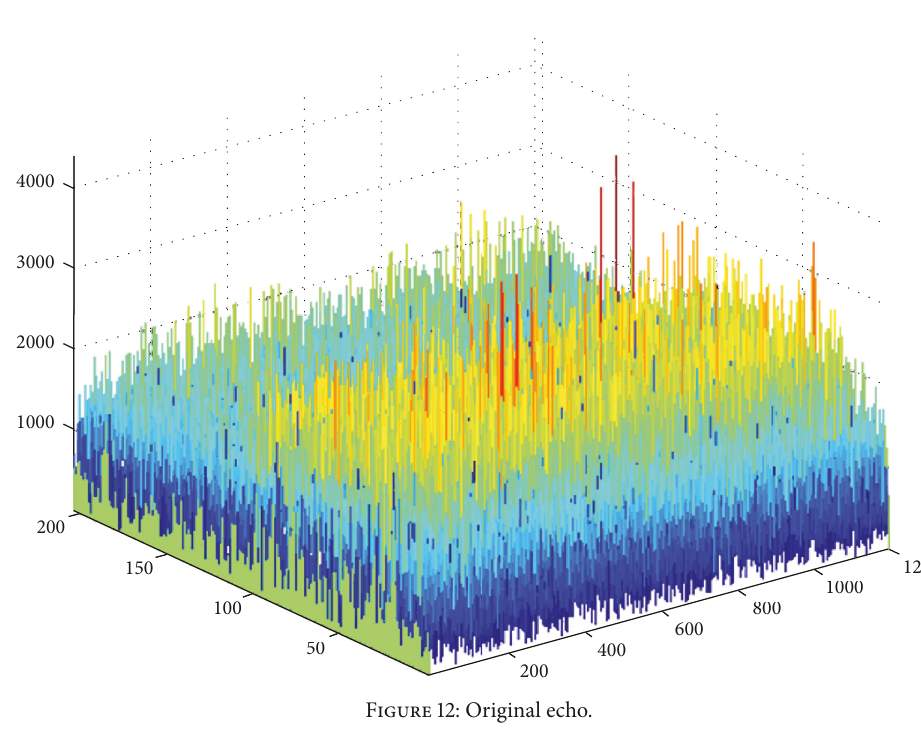
Figure 12: Original echo.